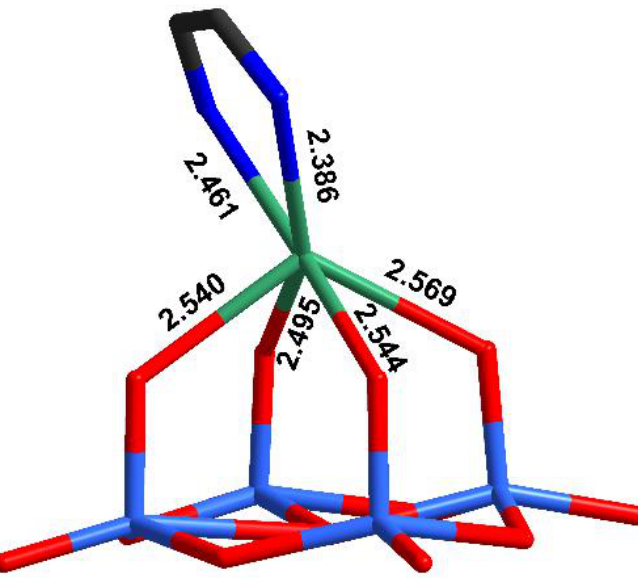
Figure 2. The coordination environment of Ag + in the crystal structure of 1 .